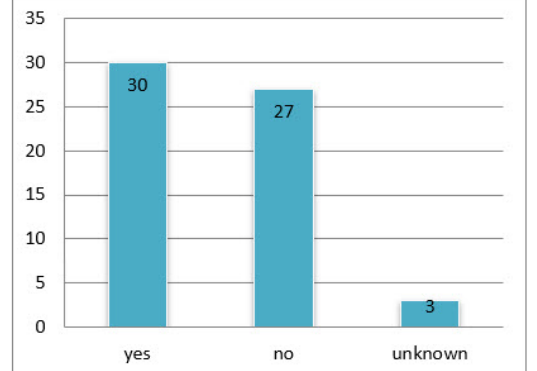
Figure 4. Perception of the effectiveness of online